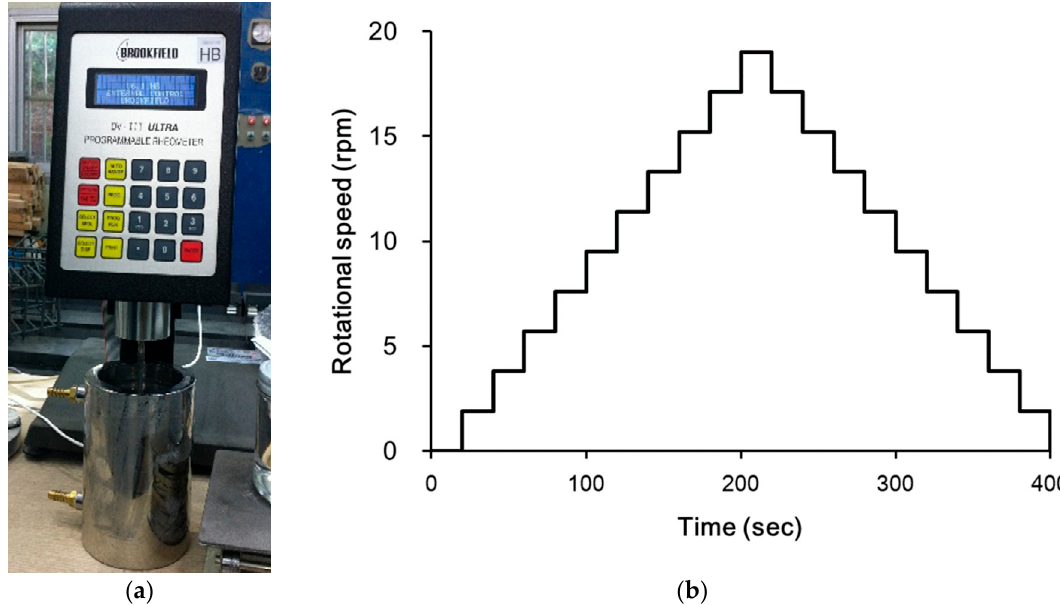
Figure 1. ( a ) Rheometer (Brookfield DV-III ULTRA) and ( b ) rotational speed protocol applied for rheometer test.